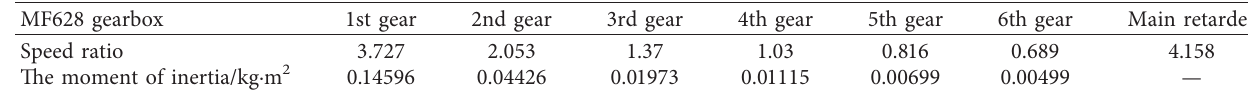
Table 2: Gearbox parameters.